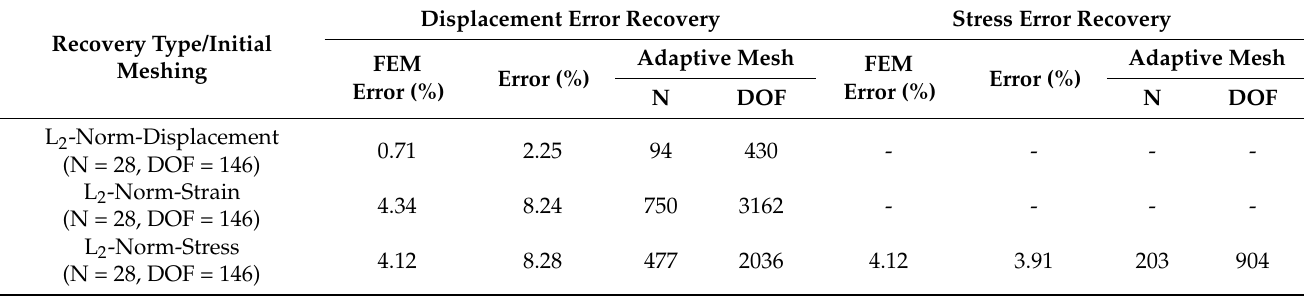
Table 7. Global errors (FEM and processed, L 2 -Norm) and number of element (N) with DOF of adaptively refined meshes considering displacement and stress recovery based analysis (quadratic triangle, 1% target